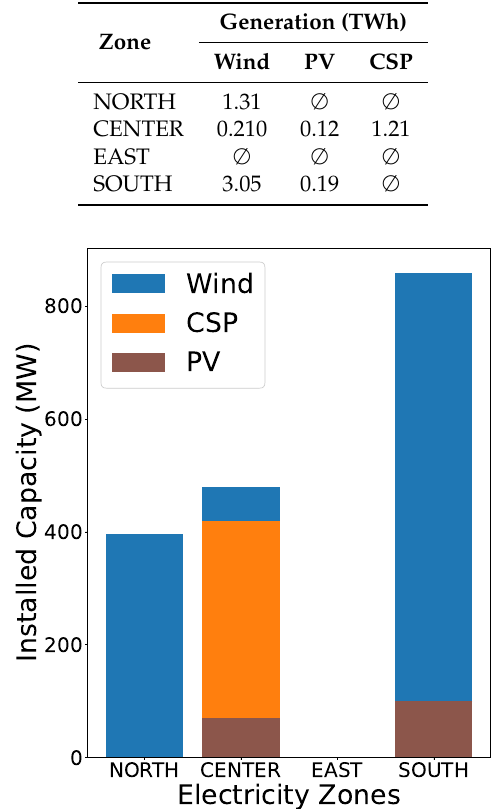
Table A3. Yearly-mean generation averaged per zone and technology observed in Morocco in 2018. Zone-technology pairs for which no capacity is installed are marked by an empty set ∅ .